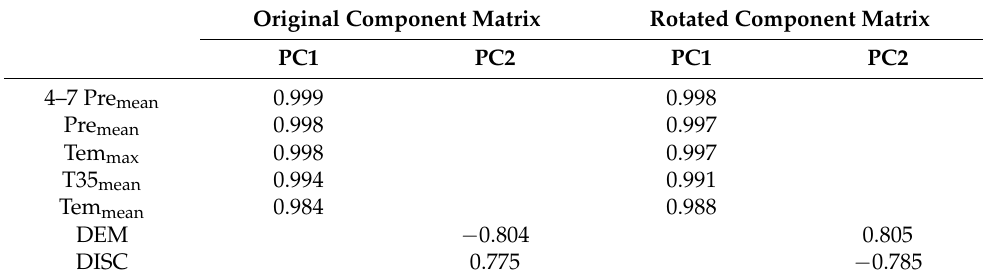
Table 3. Original and rotated component matrices.